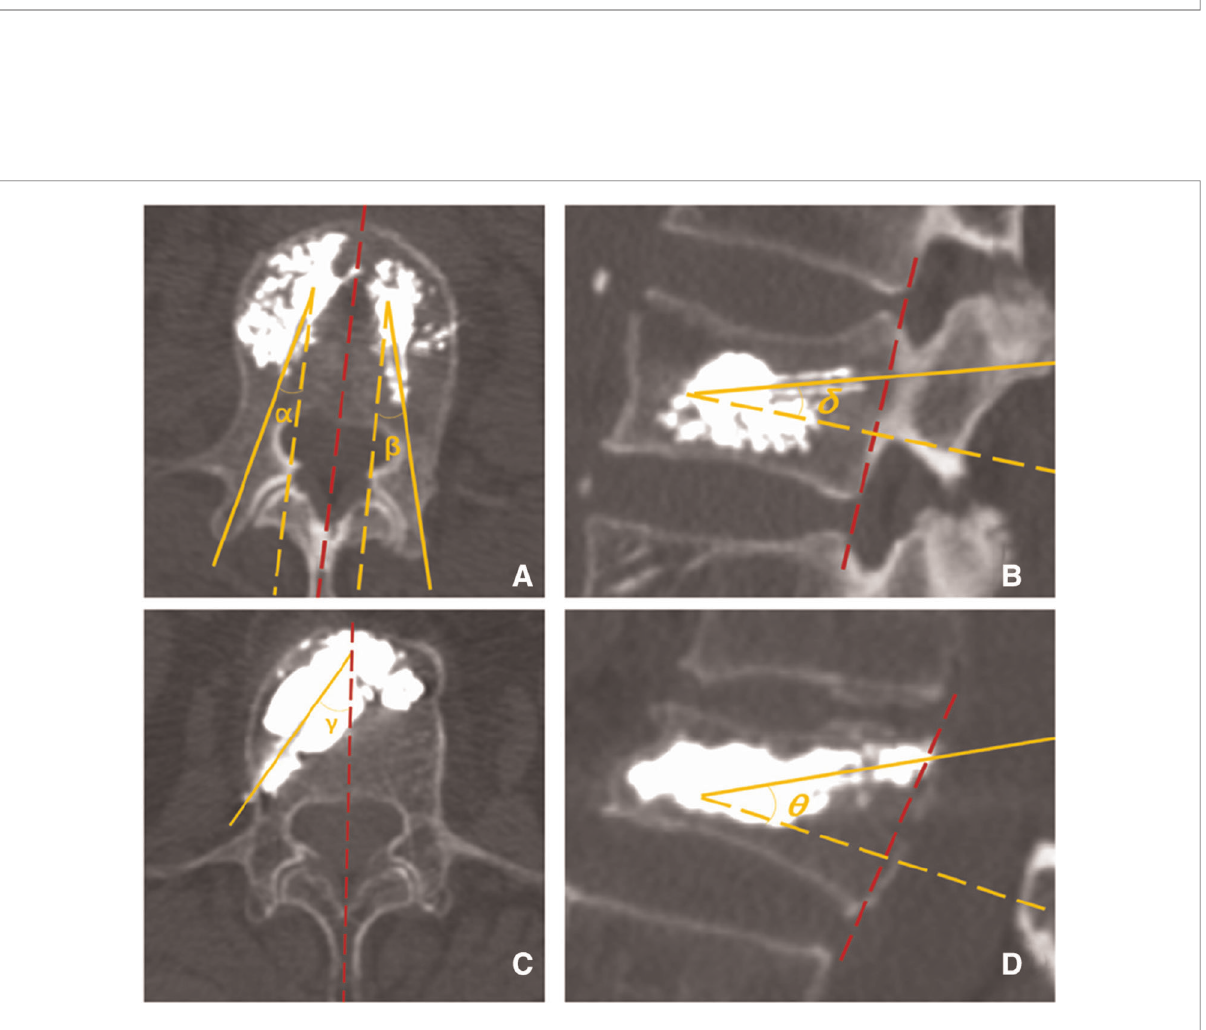
FIGURE 5 ( A ) The abduction angle α and β via the transpedicular approach. ( B ) The cranial inclination angle δ via transpedicular approach. ( C ) The abduction angle γ via the superior pedicle notch approach. ( D ) The cranial inclination angle θ via the t superior pedicle